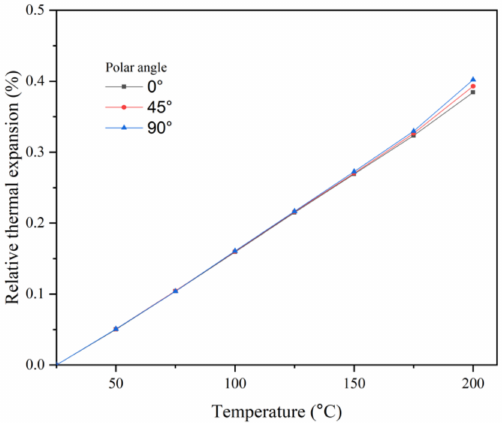
Figure 3. Relative thermal expansion for case 2 as a function of the polar angle.